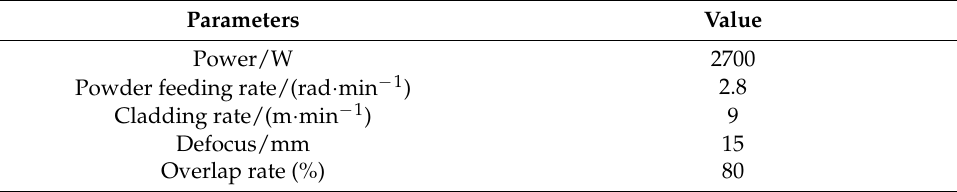
Table 3. Laser cladding